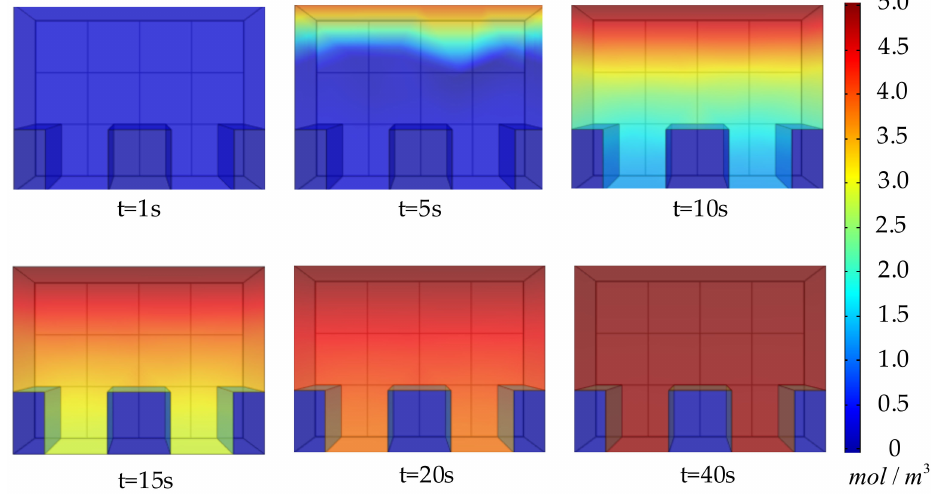
Figure 8. Simulation of the process of changing N with step changes in ambient humidity.